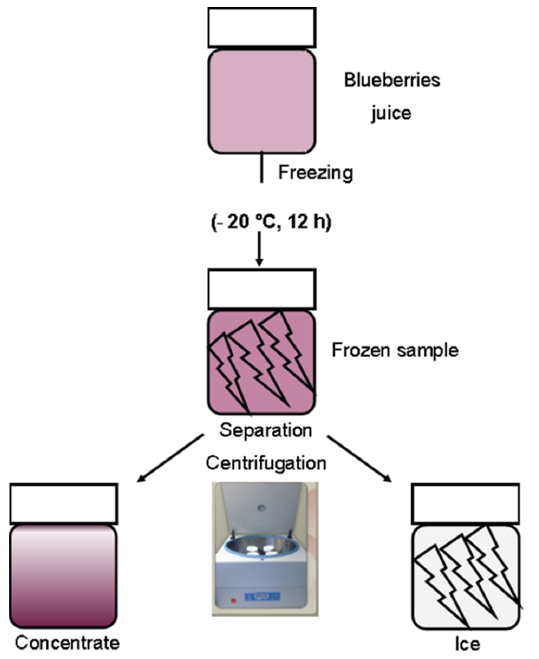
Figure 1. Schematic diagram of the experimental protocol.